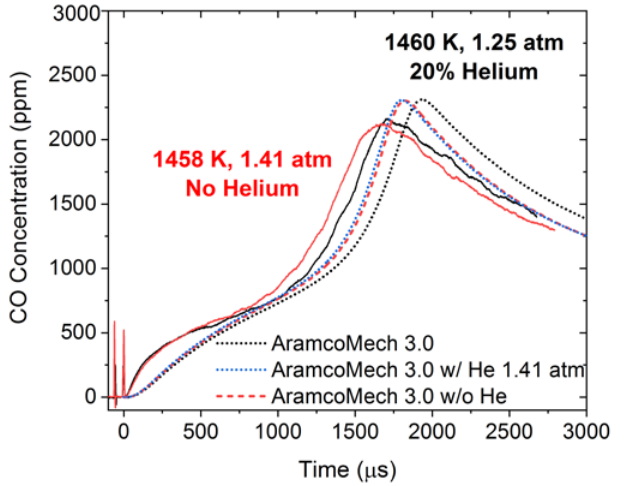
Figure 11 . Effect of helium addition on CO production and model predictions for stoichiometric oxidation of isopropanol at ~1460 K. The AramcoMech 3.0 mechanism predictions for the two runs are also shown to investigate the effect of test pressure.